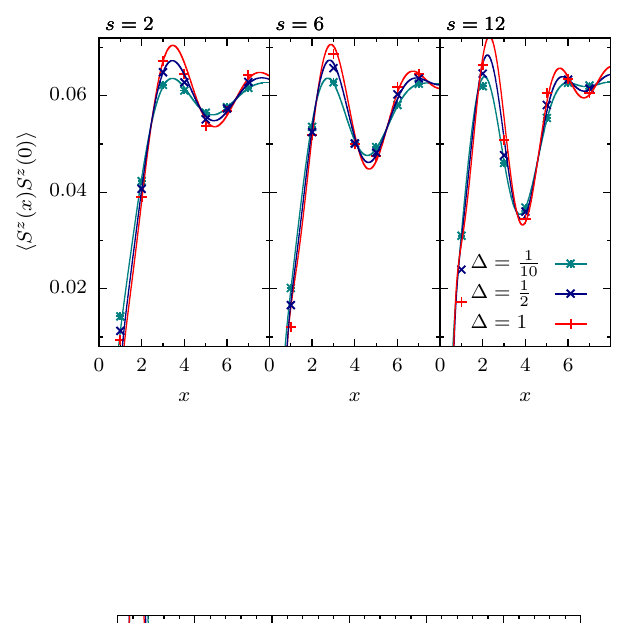
Figure 9: Transverse static real space correlation 〈 S − ( x ) S + ( 0 ) 〉 , at N = 200, M = 50 for several values of the anisotropy, for a state with momentum split in the Fermi sea by s = 12. The figure com- pares the ABACUS results (points) to the multi-component Tomonaga- Luttinger model (lines). The corre- spondence works well for distances larger than a handful of sites.